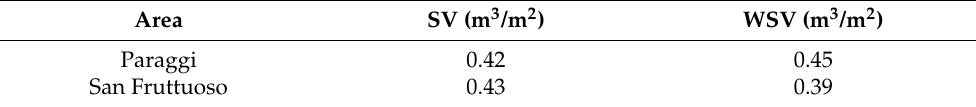
sampled slopes in Paraggi and San Fruttuoso